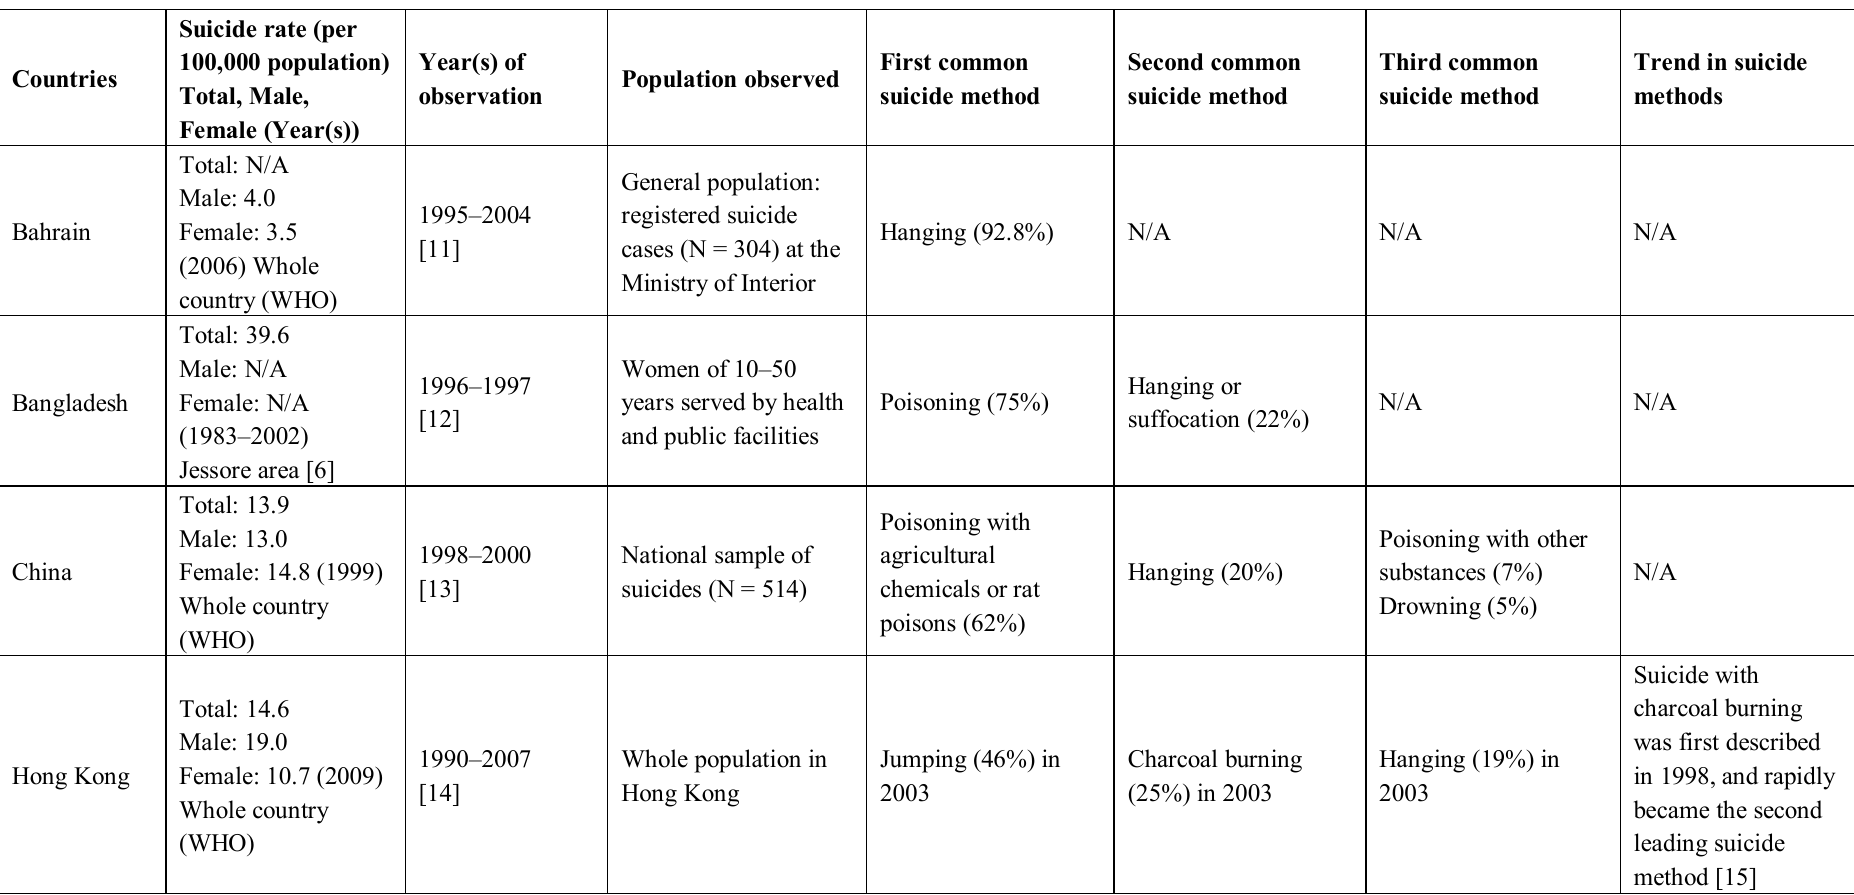
Table 1. Suicide methods in